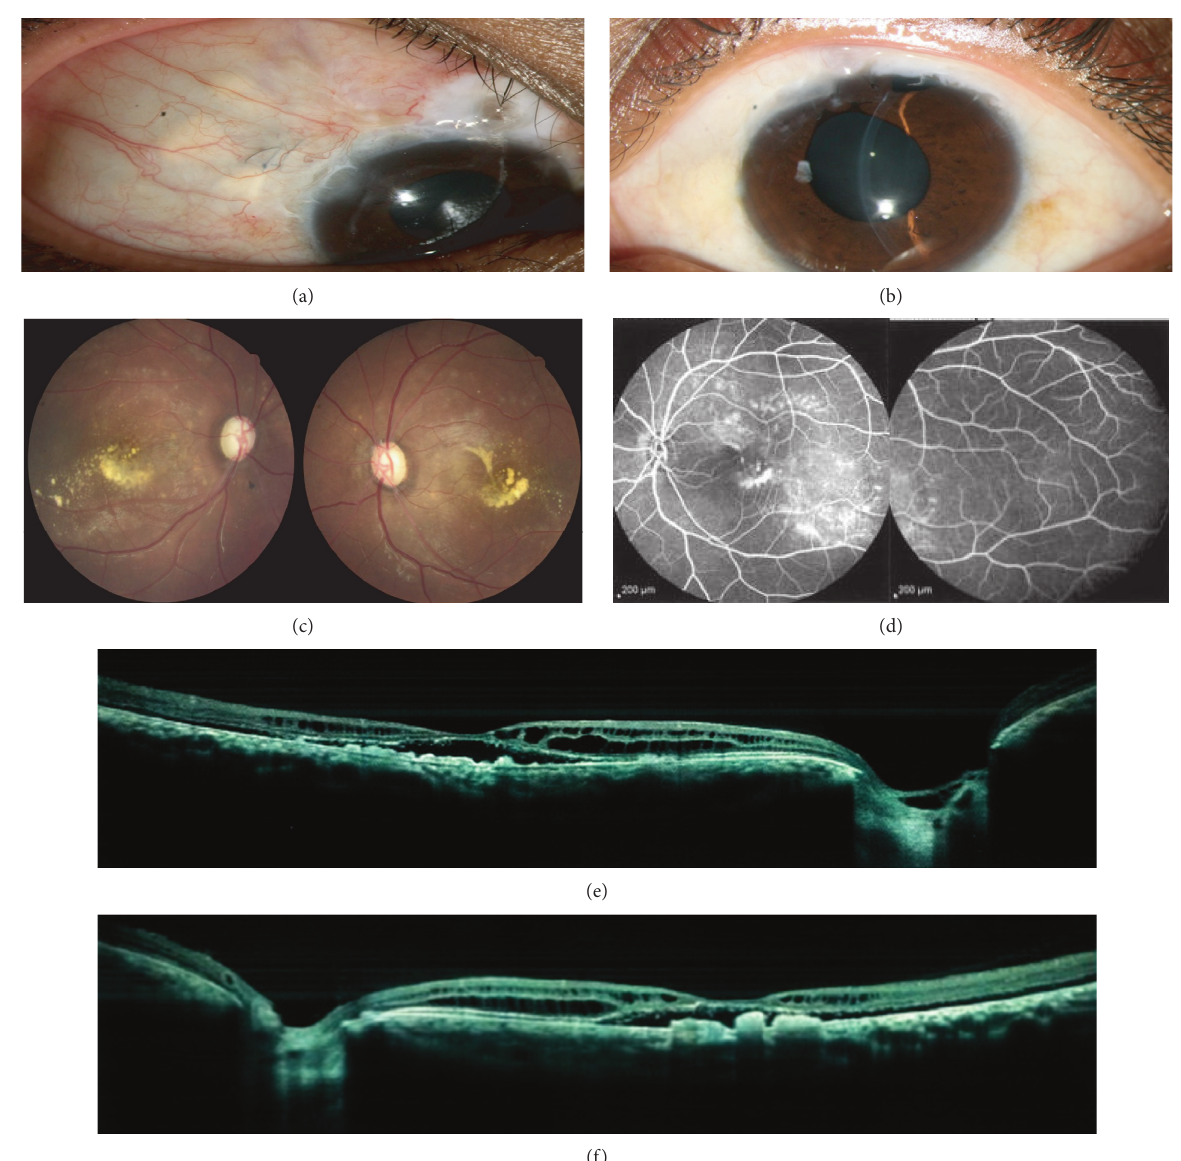
Figure 1: Slit photograph of right (a) and left (b) eyes of patient number 1. She underwent surgical peripheral iridotomy (PI) and trabeculectomy in her both eyes for angle-closure glaucoma. Fundus photo of right and left eyes (c) shows total cup-to-disc ratio and yellow subfoveal materials. Fluorescein angiography of left eye with peripheral views (d) shows staining of yellow vitelliform materials without peripheral leakage. Optical coherence tomography (OCT) of right (e) and left (f) eyes show subfoveal hyporeflective space in both eyes with elongated photoreceptors and intraretinal schisis cavities in inner nuclear layer (INL) and outer nuclear layer (ONL). There are also deposits of debris in the subretinal space mimicking RPE hypertrophy in both